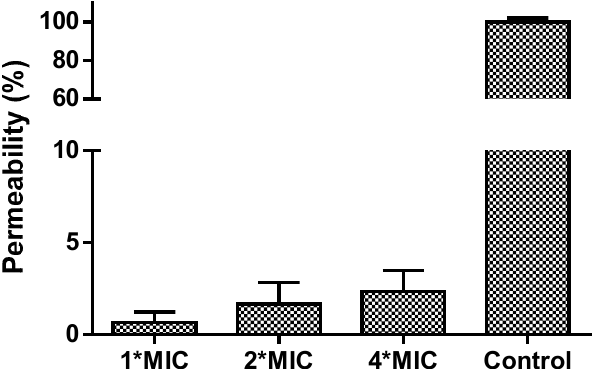
Figure 3. The cell permeability of C. albicans treated for 2 h by Tat-loop at 1-fold, 2-fold and 4-fold of MIC. The membrane permeabilized cells by 70% isopropanol were used as the positive control (100% permeability).